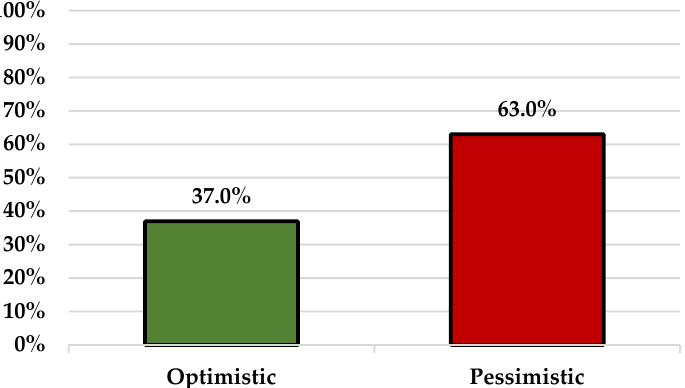
Figure 2. Communication with vaccine-hesitant patients .